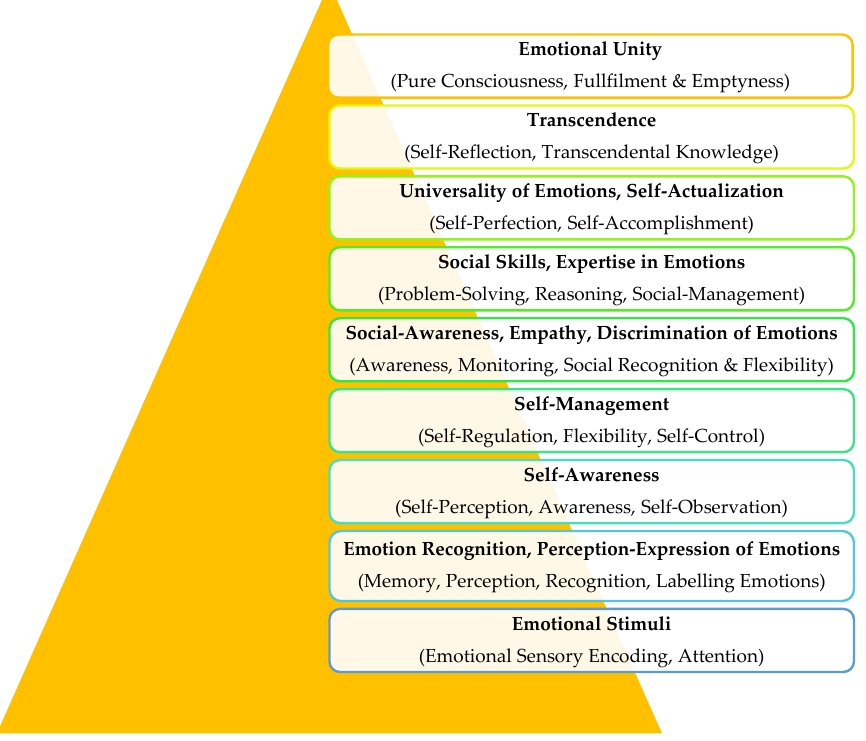
Figure 2. The cognitive and metacognitive processes to move from a layer to another.